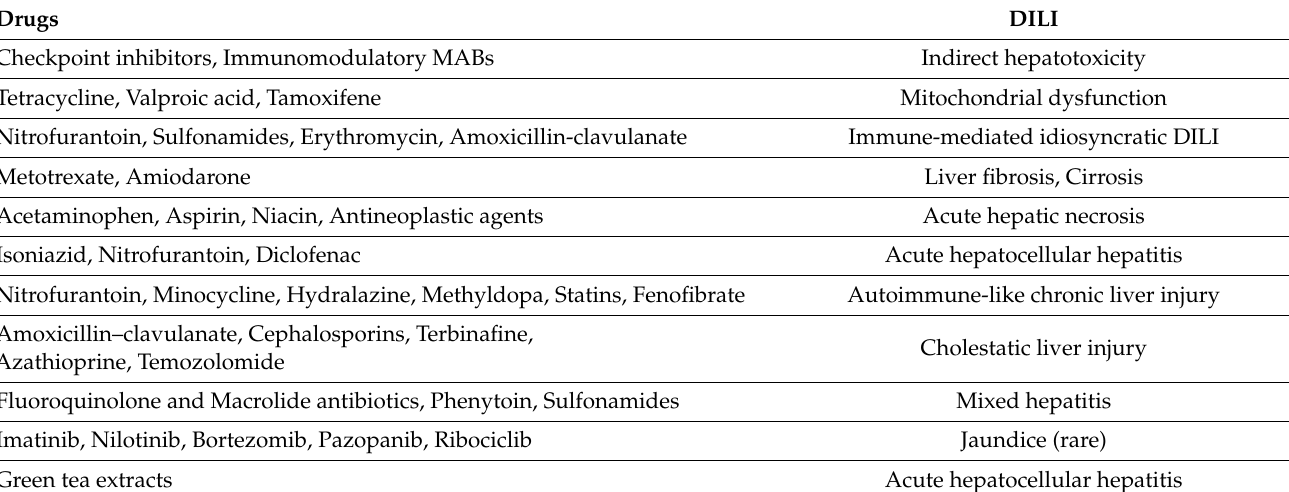
Table 1. Drugs inducing